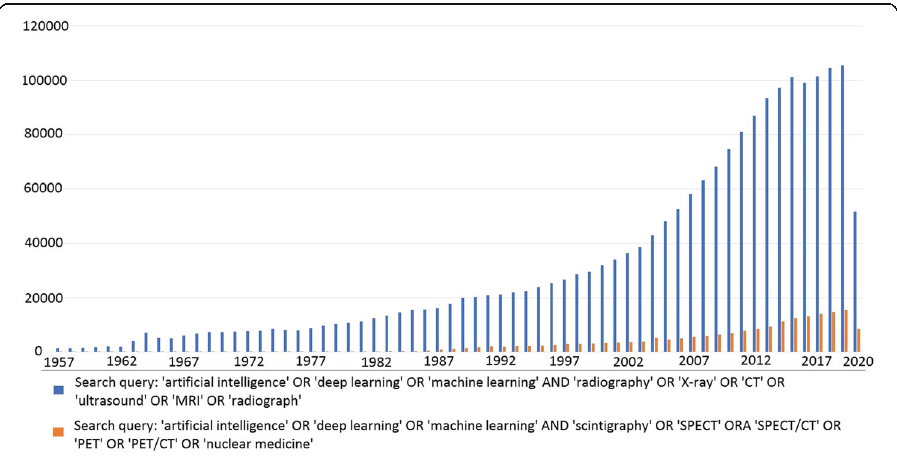
Fig. 1 Temporal trend of publications on AI-based applications in radiology and nuclear medicine